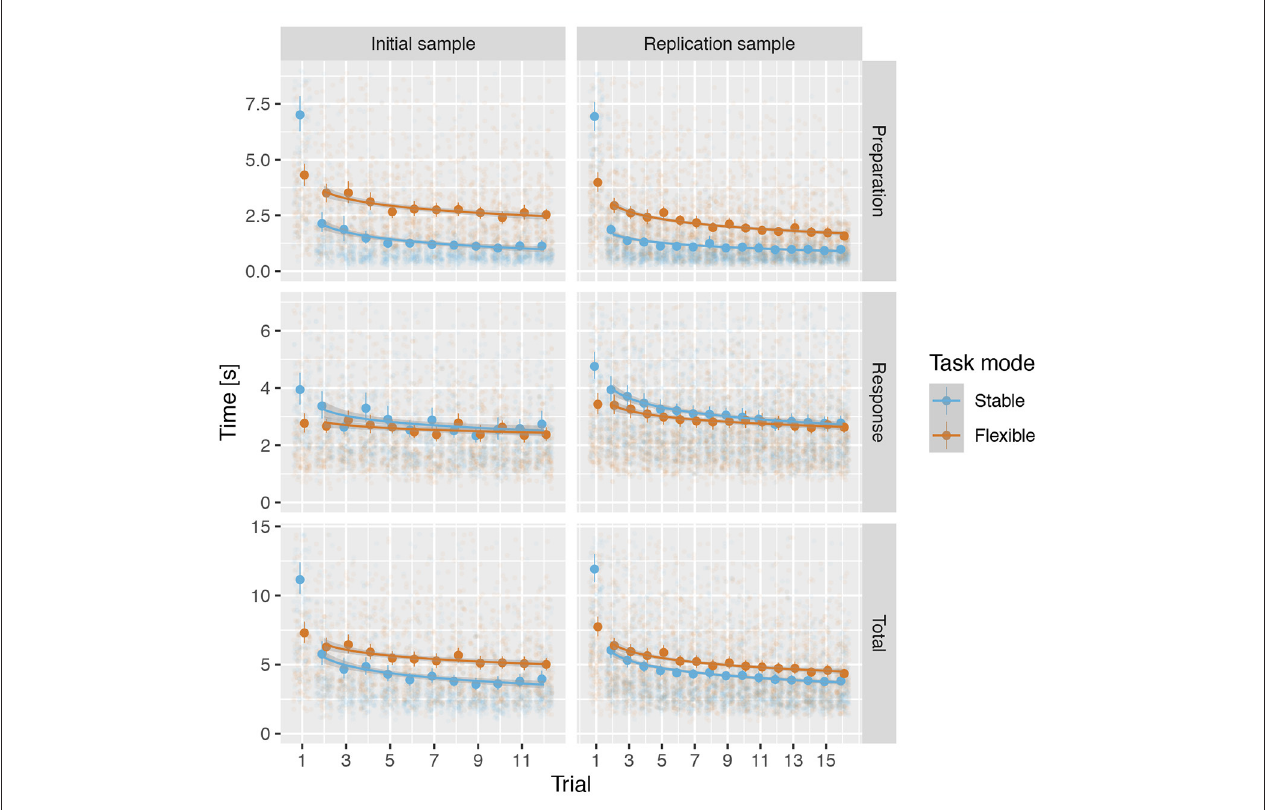
FIGURE 4 | Median reaction times across all rules for each trial for both samples in the stable and the flexible task modes. The circles show the median reaction times and the handles show the 95% confidence intervals. The lines show the predicted values based on a mixed linear regression model and the shading shows the standard error of the predicted